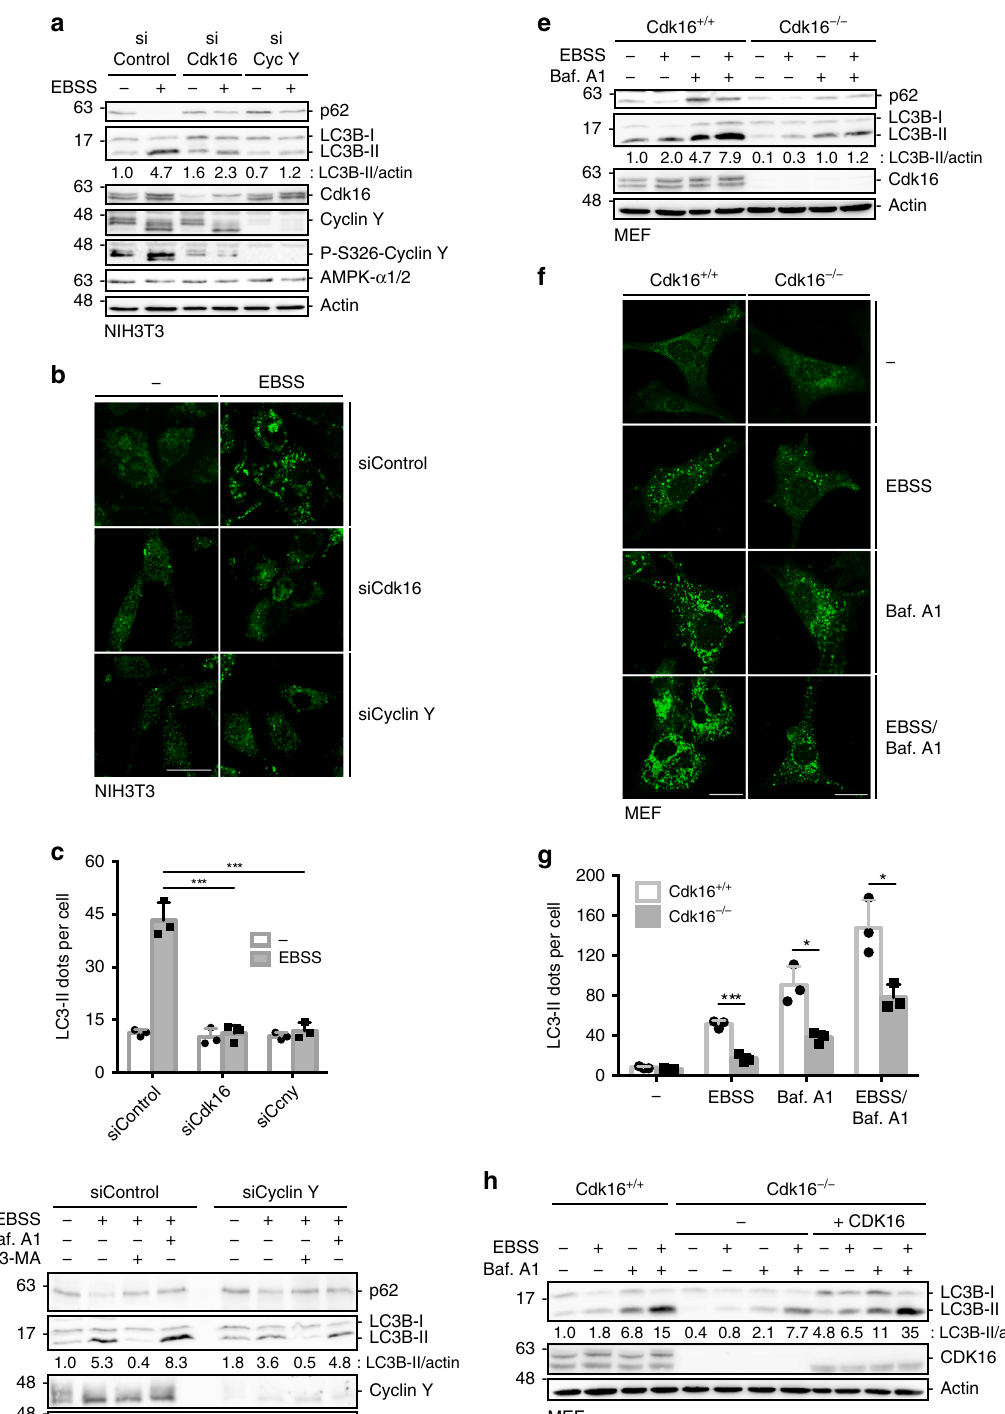
(Supplementary Fig. 6a – c). Flux inhibition by the lysosomal protease inhibitors Pepstatin A (PepA) and E64, or by Baf. A1, led to an additional increase of LC3-II and LC3 puncta (Supplementary Fig. 6d – f). 3-MA abrogated the ability of Cyclin Y/CDK16 to stimulate autophagy (Supplementary Fig. 6d – f). Also, Cyclin Y/CDK16-KR and Cyclin Y-AA/ CDK16 were less ef fi cient in inducing autophagy (Supplemen- tary Fig. 6a – c). These results con fi rm the autophagy-promoting activity of Cyclin Y/CDK16 complexes in human